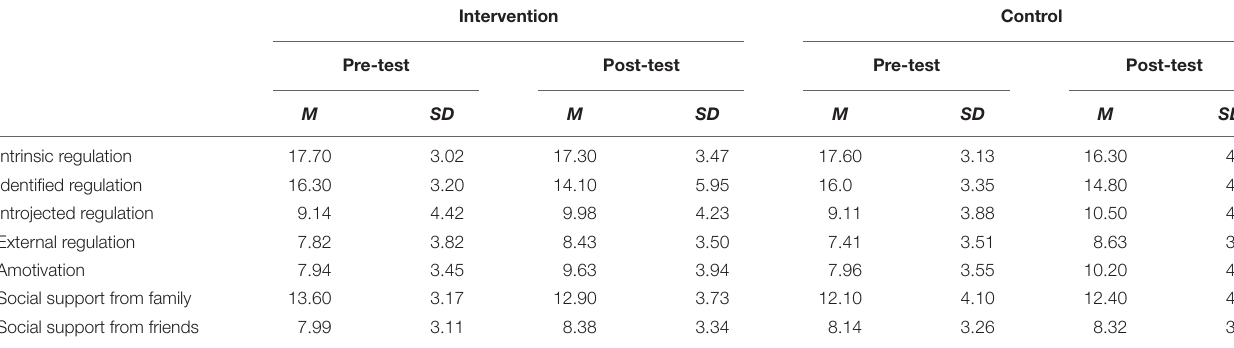
TABLE 2 | Mean and SD of intervention and control groups in pre- and post-test condition.